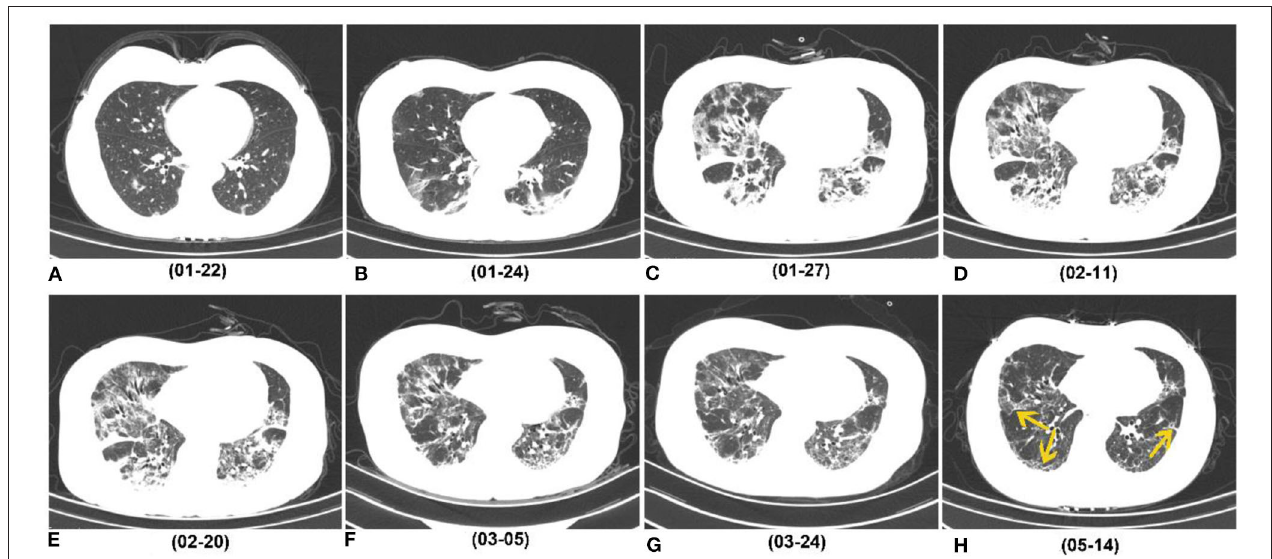
FIGURE 3 | Series of follow-up CTs of a 40-year-old woman with COVID-19 who caught a fever on January 19, 2020 and was admitted at hospital on January 27, 2020. (A) Initial chest CT on January 22 (3 days after symptoms onset) showed sporadic GGO in bilateral lower lobes. (B–E) Two days later, consolidation appeared. Whereafter, the extent of GGO and consolidation enlarged, and reached its peak on February 11, and remained the peak level until February 20. (F,G) At the recovery stage, lesions were gradually absorbed. (H) On May 14 (116 days after symptoms onset), most consolidations were absorbed, while irregular interfaces and parenchymal bands were observed as evidence of fibrotic change (yellow arrow). COVID-19, coronavirus disease 2019; GGO, ground-glass